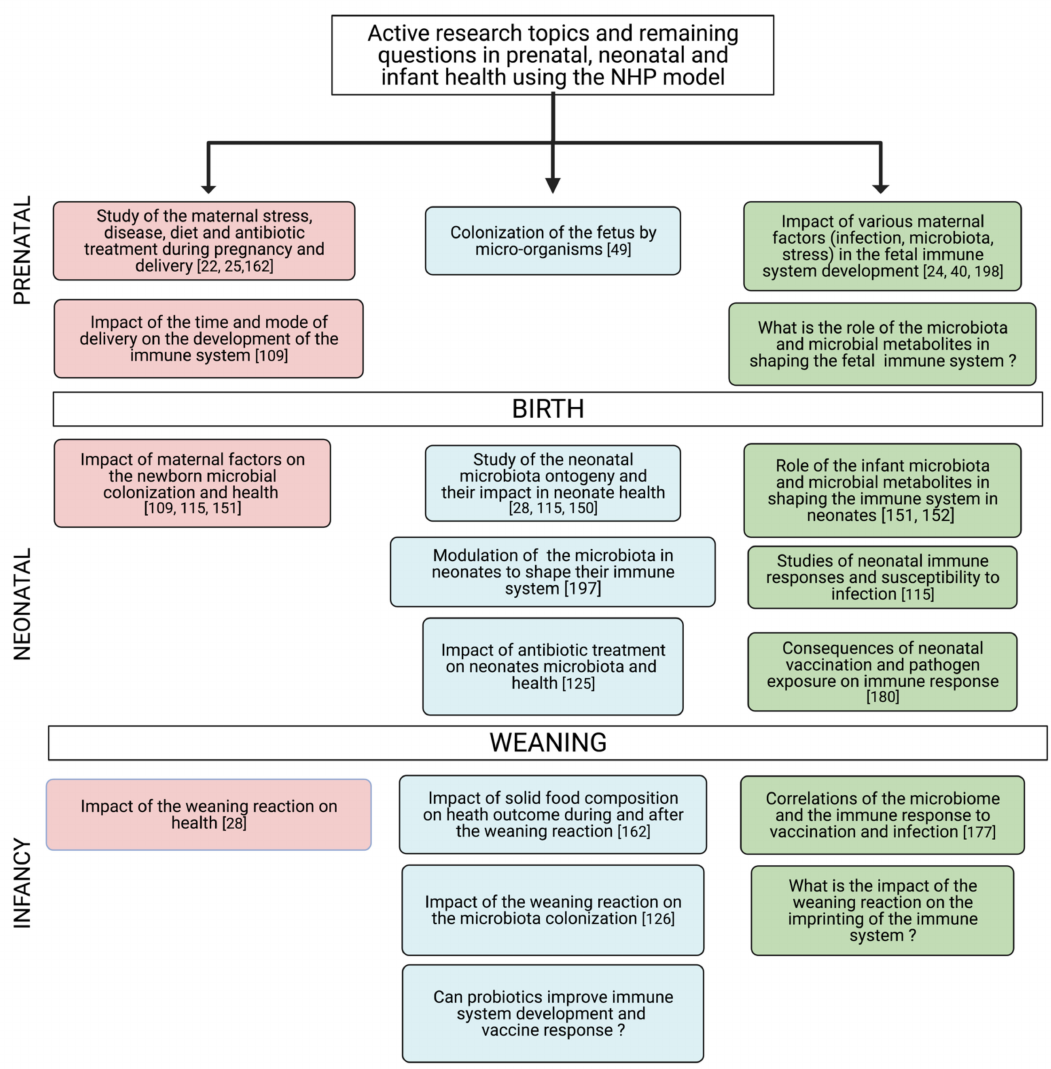
Figure 3. Summary of active research topics and questions to address the relationship between the mi- crobiota and the immune system in the NHP model. Pink boxes represent the mother or parental- associated parameters, blue boxes represent microbiota studies, and green boxes represent immune system